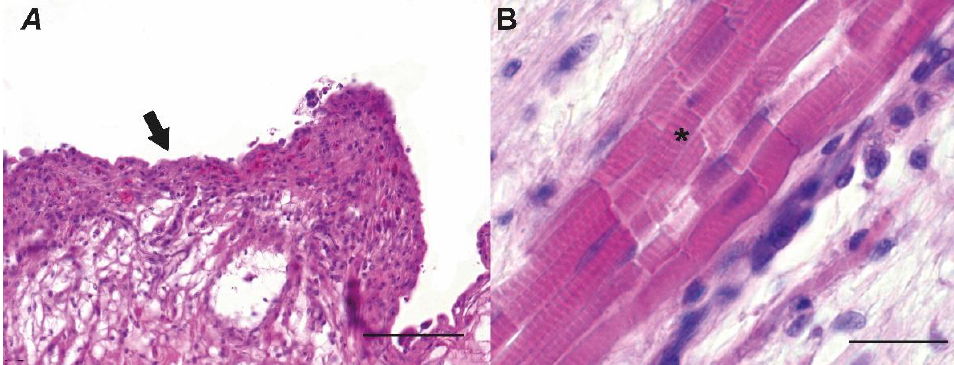
Figure 2. Histological characteristics of sagittal sections of esophagus walls of Nile tilapia. ( A ): mucosa folds of the esophagus covered with layer of squamous epithelium (arrow), ( B ): pyloric zone with striated muscle layers (asterisk). Scale bar = ( A ): 100 µ m; ( B ): 25 µ m.